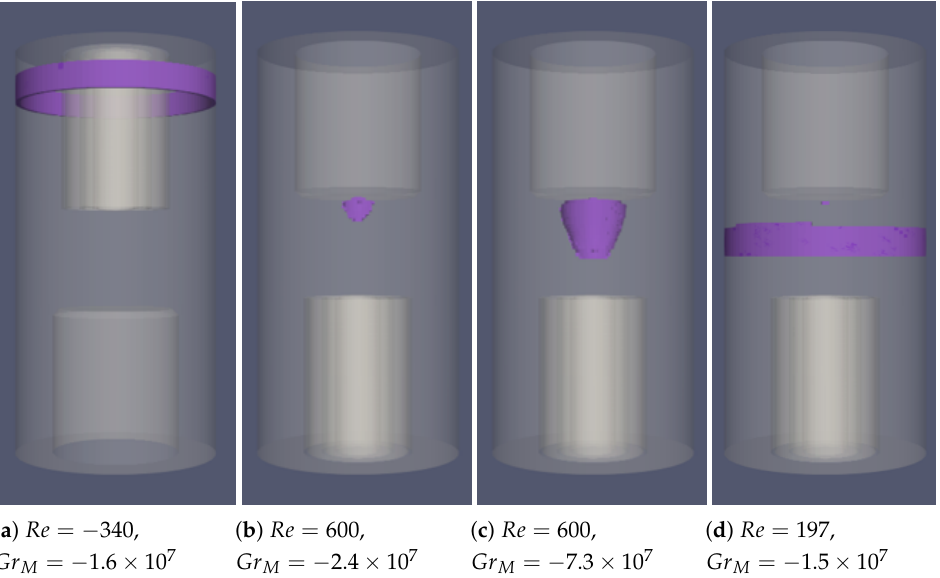
Figure 7. Location of instabilities in the down-flow reactor ( a ) and up-flow reactor ( b – d ) for varying H 2 in the IRL. Figures relate to the markings in Figure